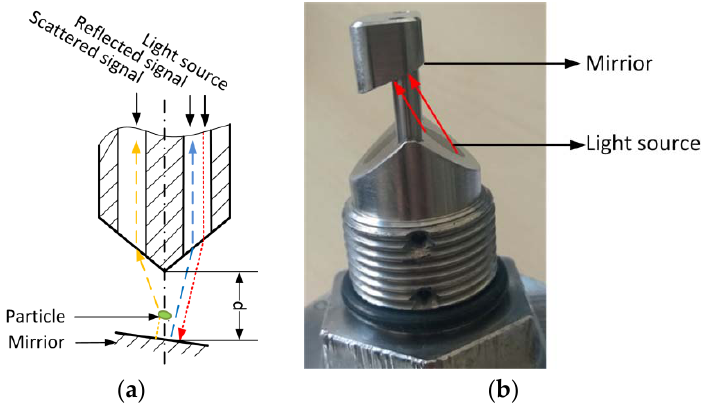
Figure 1. The AFG sensor, showing: ( a ) the measurement principle, d refers to the distance between the sensor and the mirror and ( b ) the device with an adjustable